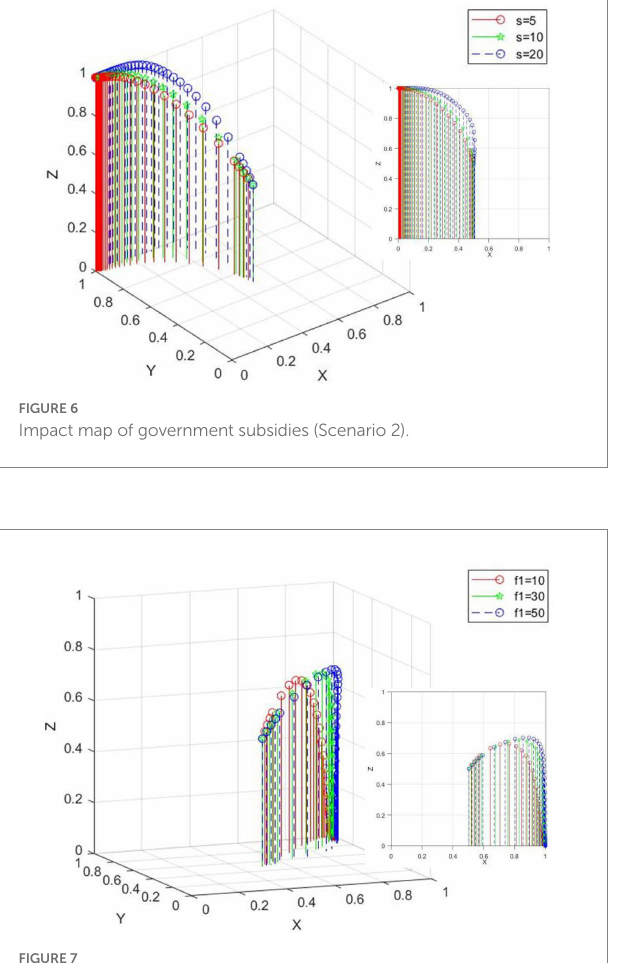
FIGURE 7 Map of the impact of the government on the amount of fines imposed on marine ranching companies (Scenario 1).